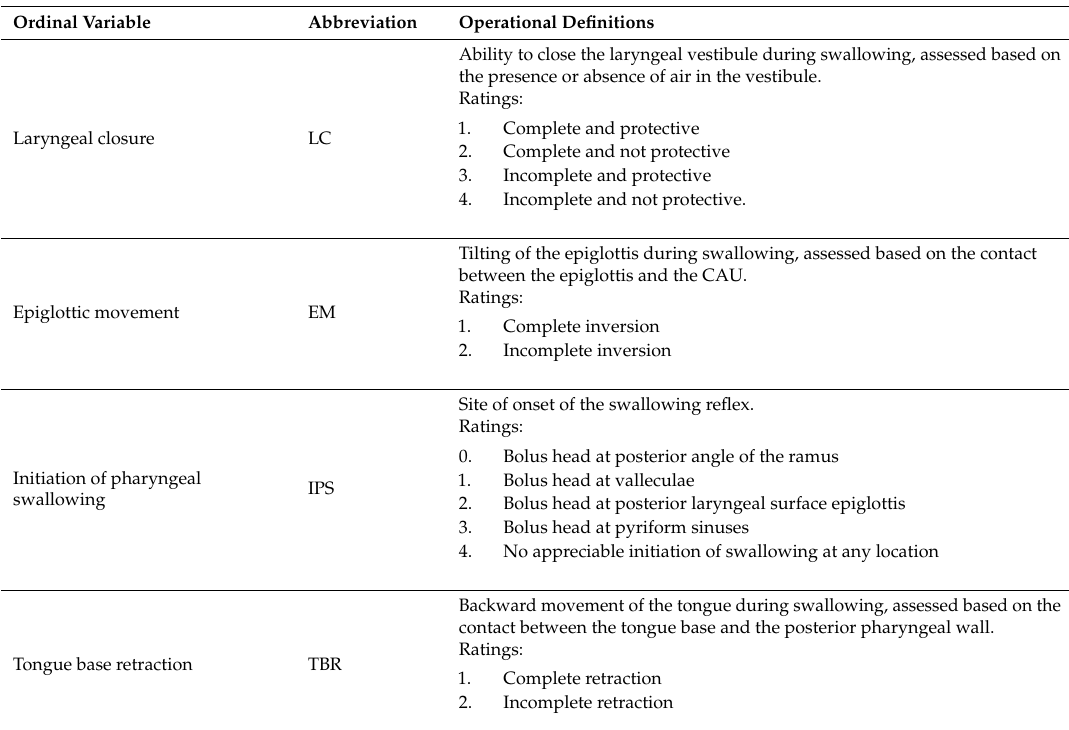
Table 4. Ordinal videofluoroscopic